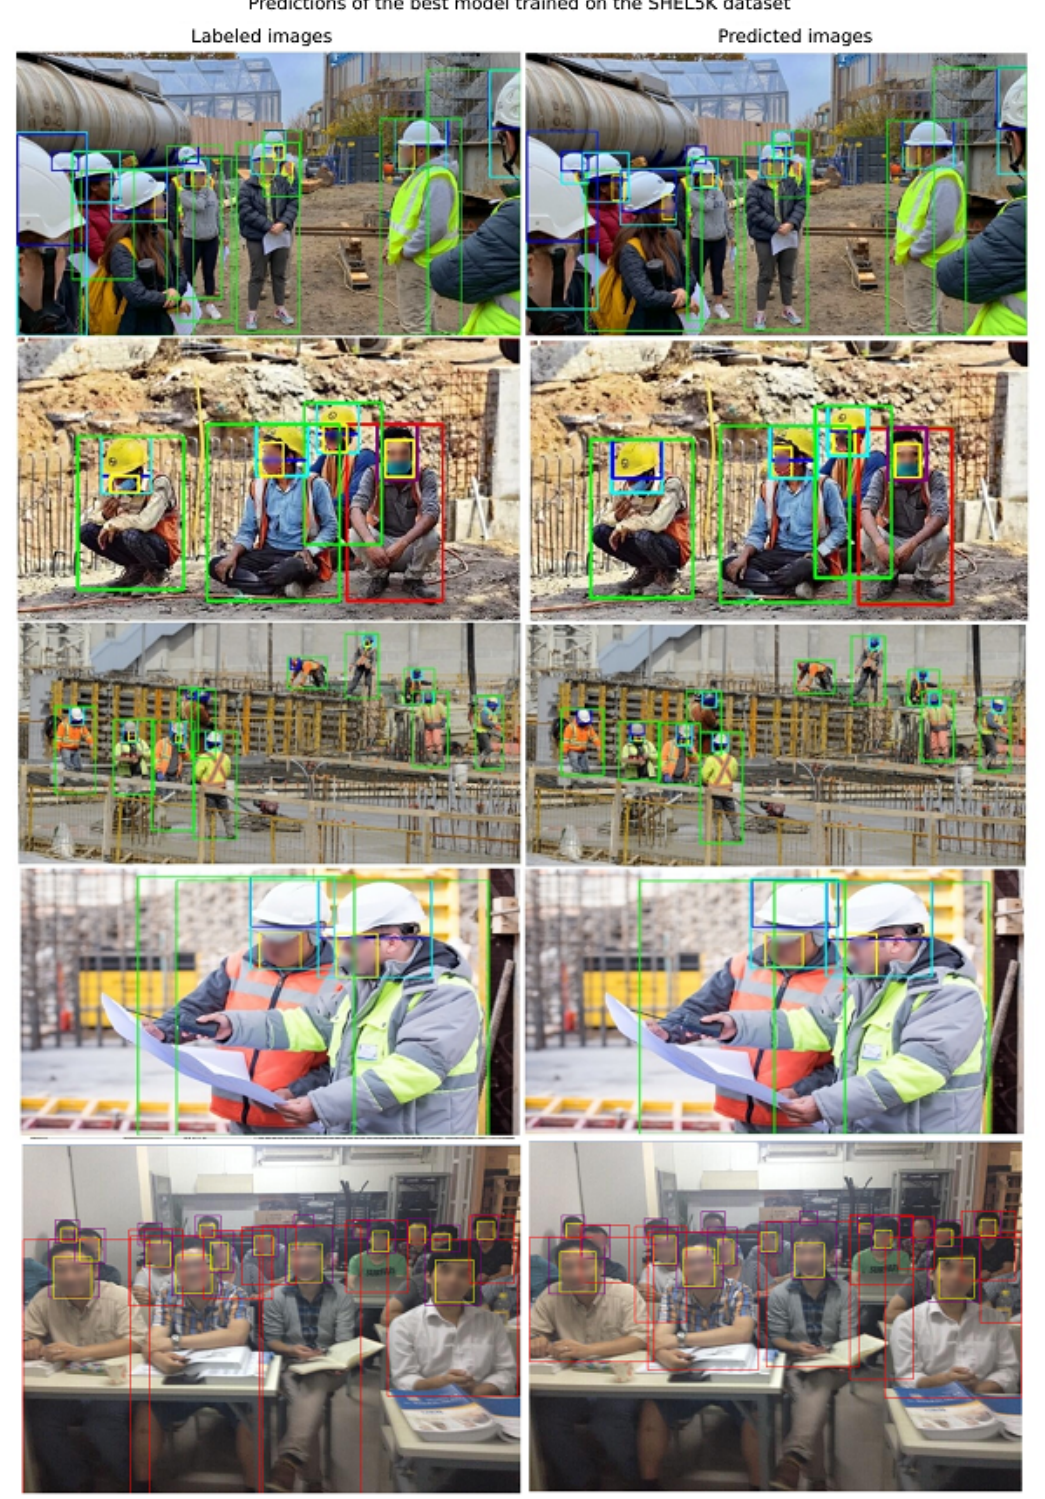
Figure A1. Predictions of the best model trained on the SHEL5k dataset and the ground truth labels of the sample